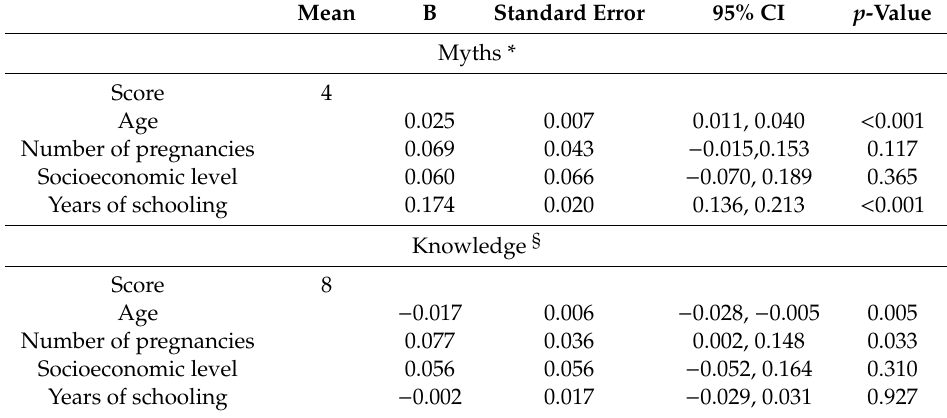
Table 4. Myths and knowledge scores and their covariables.